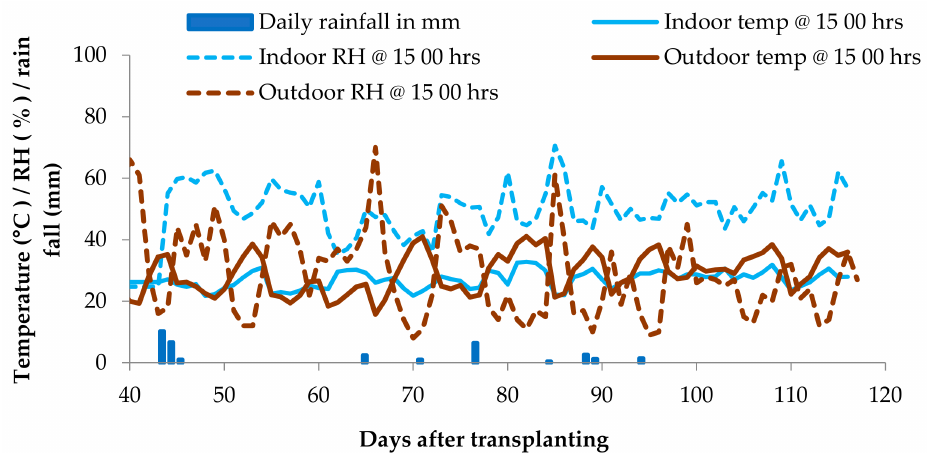
Figure 3. Daily indoor and outdoor air temperature ( ◦ C), relative humidity (RH) (%), and rainfall (mm). See Table 2 for treatment descriptions.